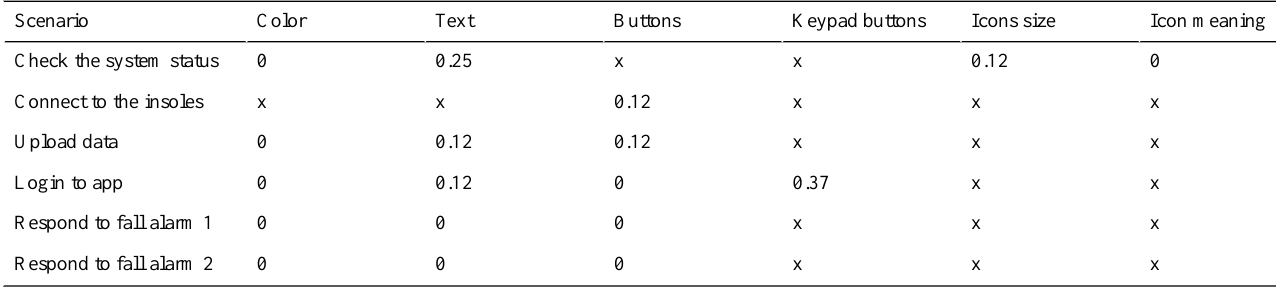
Table 15. Likert items severity rating (range 0-4, 0=no problem, 4=most severe problem) for interface ergonomics by scenario. Some Likert items did not apply to certain scenarios. An x indicates that there was no Likert statement for that particular interface aspect for that scenario.